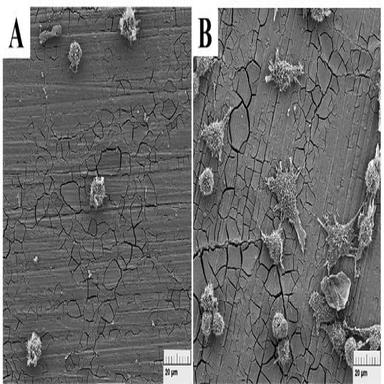
SEM images of L929 cells growing on the surface of A) WE43, B) WE43 24h HF.